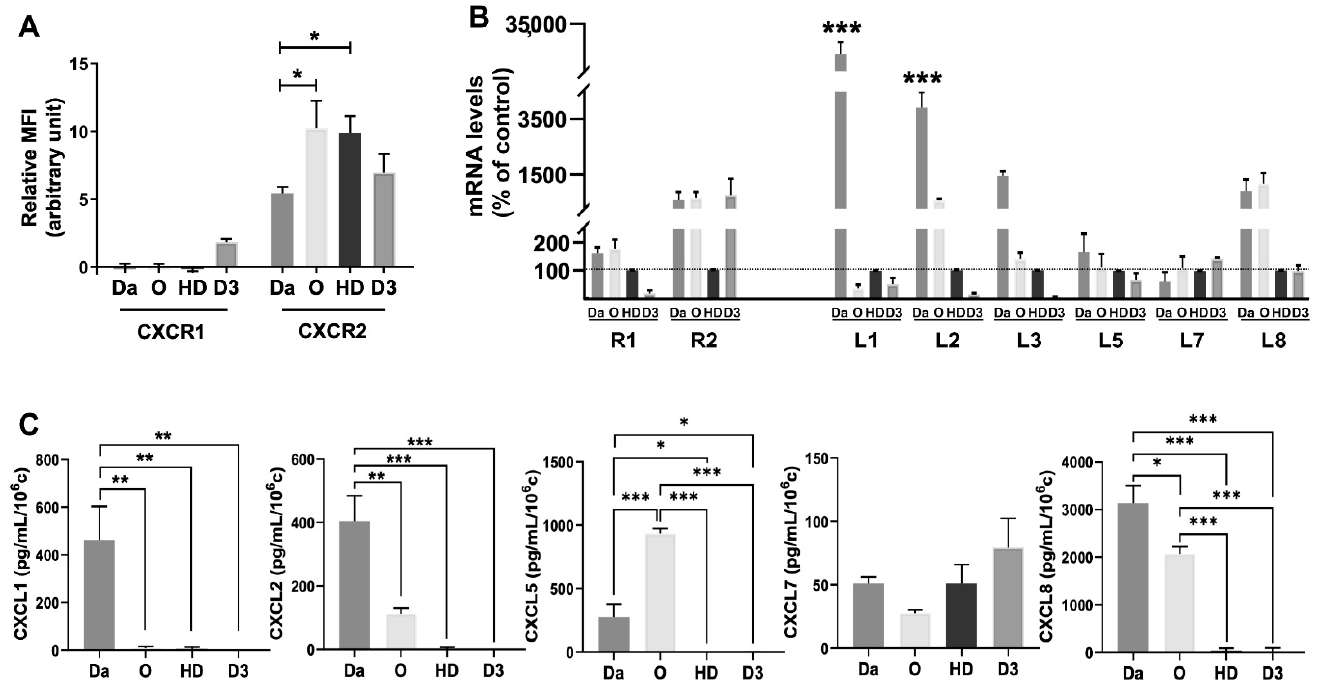
Figure 2. MB sensitive and irradiation-resistant cells expressed ELR+CXCL-CXCR markers. ( A ). Labelling of CXCR1/2 membrane receptors by flow cytometry on Daoy (Da, n = 4), ONS-76 (O, n = 4), HD-MB03 (HD, n = 3), and D341Med (D3, n = 3) cells. ( B ). Human CXCR1/2 (R1/R2) and ELR+CXCL (L1, L2, L3, L5, L7 and L8) mRNA expression level in Daoy, ONS-76, HD-MB03, and D341Med cells. The mRNA level was determined by qPCR. Results are expressed as percentage of control (HD-MB03), n = 3. ( C ). ELR+CXCL (CXCL1, 2, 5, 7, 8) dosage by ELISA assay in Daoy, ONS-76, HD-MB03, and D341Med WT cells, n = 3. Statistics were performed by two-way method ANOVA. * p < 0.05, ** p < 0.01, *** p < 0.001. For this figure, Daoy = Da, ONS-76 = O, HD-MB03 = HD, D341 = D3.